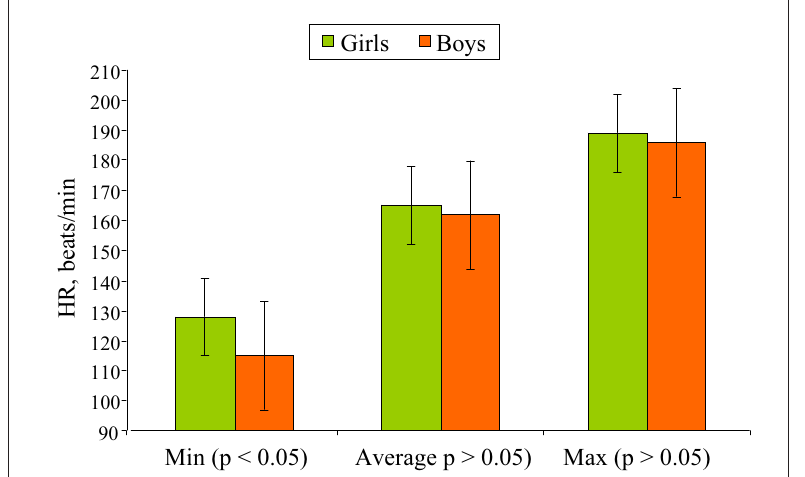
Figure 1. Heart rate indices of juvenile sports dancers during the Standard dance contest programme